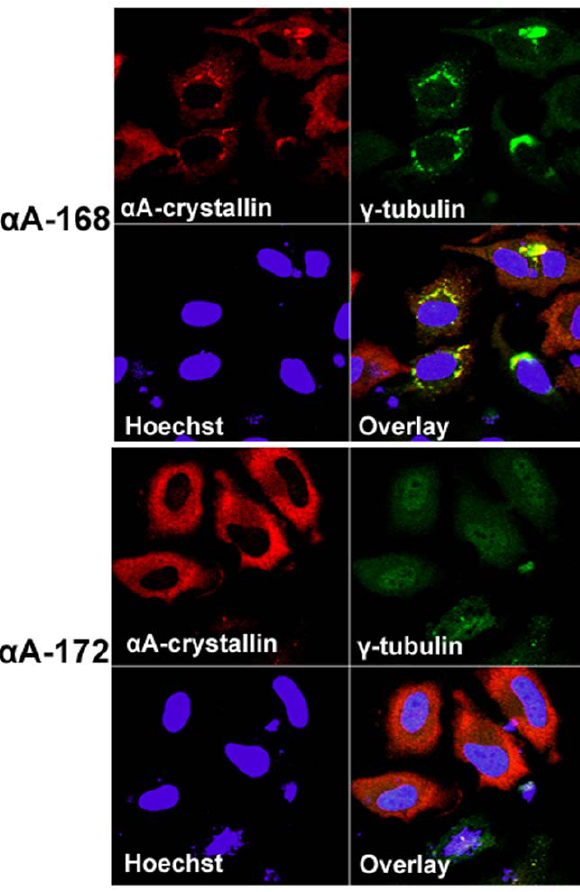
Figure 13. Validation for aggresomes in HeLa cells transfected with YFP- a A168 and YFP- a A172 constructs. 48 hours post- transfection cells were double immunostained with a A-crystallin (Red) and c -tubulin (Green) antibodies. The c -tubulin did not co-localize in YFP a A-172 expressing cells, but co-localization signal was evident in YFP- a A168 expressing cells. Nuclei were stained with Hoechst 33342 (blue).